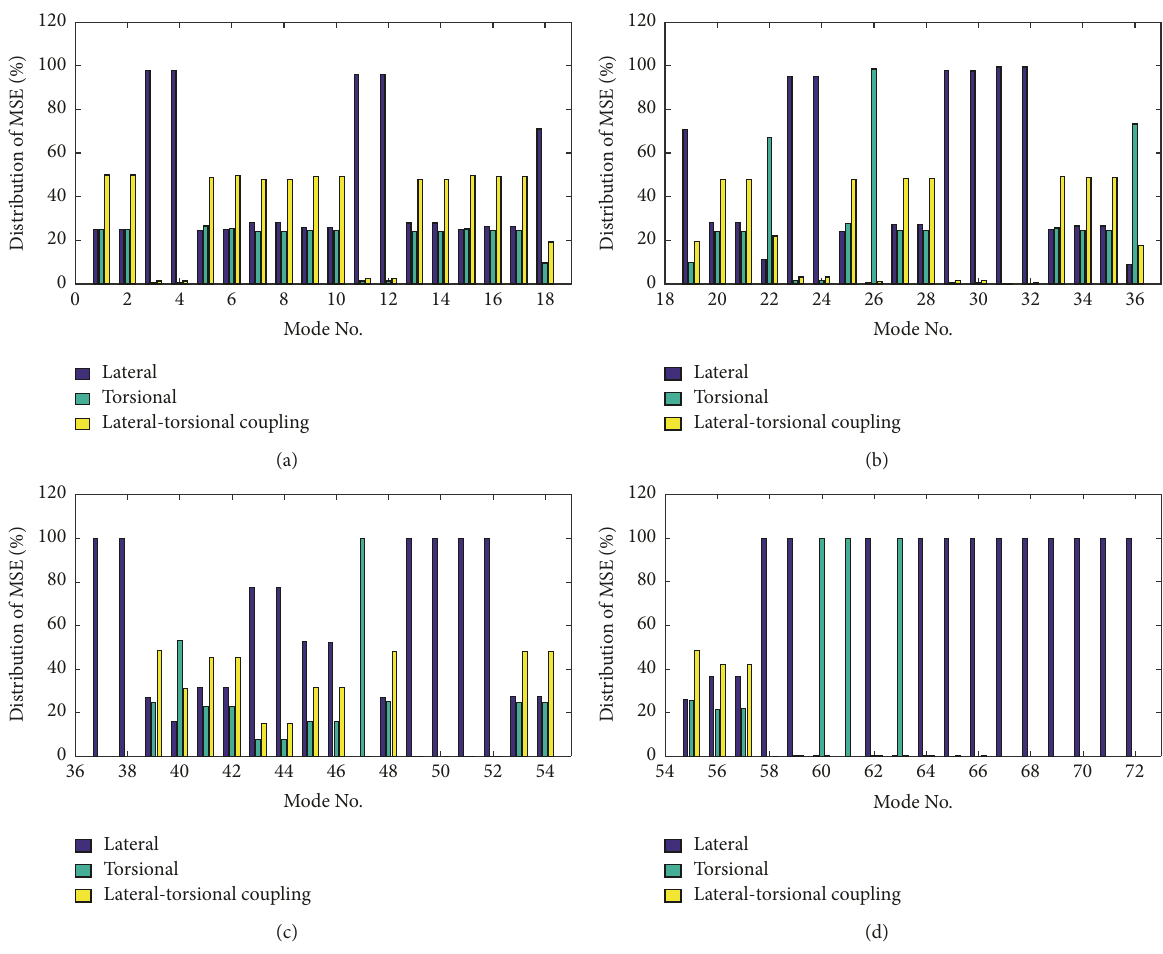
Figure 9: MSE distribution of each mode associated with the lateral, torsional, and lateral-torsional coupling modes: (a) the first 18 modes, (b) the 19 th ∼36 th modes, (c) the 37 th ∼54 th modes, and (d) the 55 th ∼72 nd